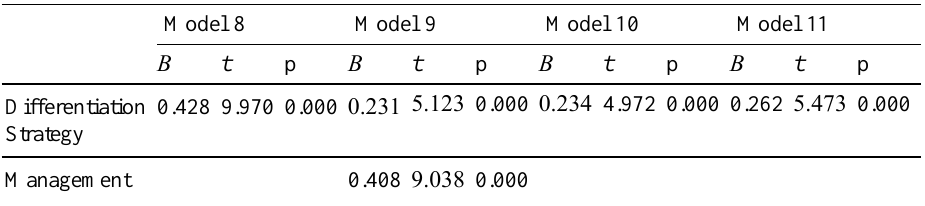
Table 9. The effects of differentiation strategy and BCs